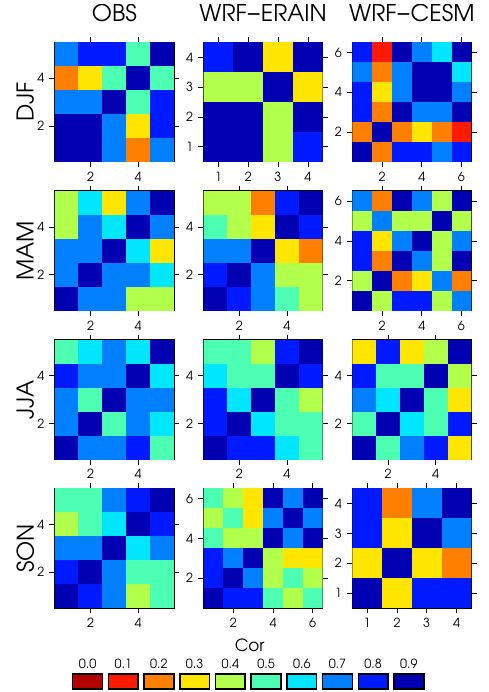
Figure 3. Temporal cross-correlation matrices between all regional series. The calculation, as the definition of regions, is carried out independently for each dataset and season. The order of matrices is from region 1 (bottom left) to region 6 (top right), and the spatial distribution of the regions is shown in Fig. 2. Note that all matrices are symmetrical with 1 across the